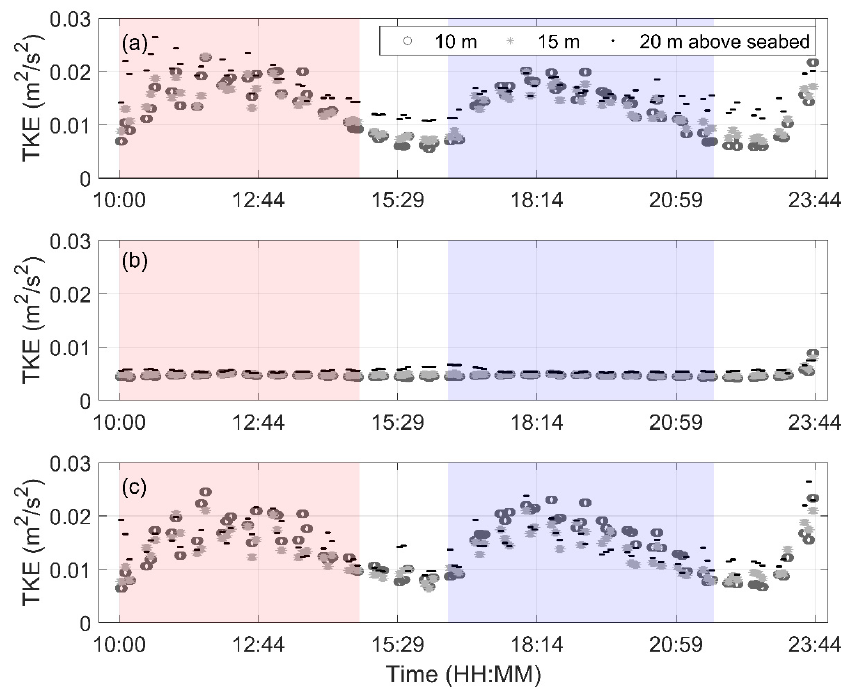
Figure 8. Total TKE estimated from ( a ) the SB, ( b ) MA, and ( c ) SWT decomposition methods at bottom tip height (10 m above seabed), hub-height (15 m above seabed), and top tip (20 m above seabed). Time-series show an approximately 12-hours period, measured on the 26th April 2018 at measurement location CTb3. Red area shows ebb tide and blue area shows flood tide.